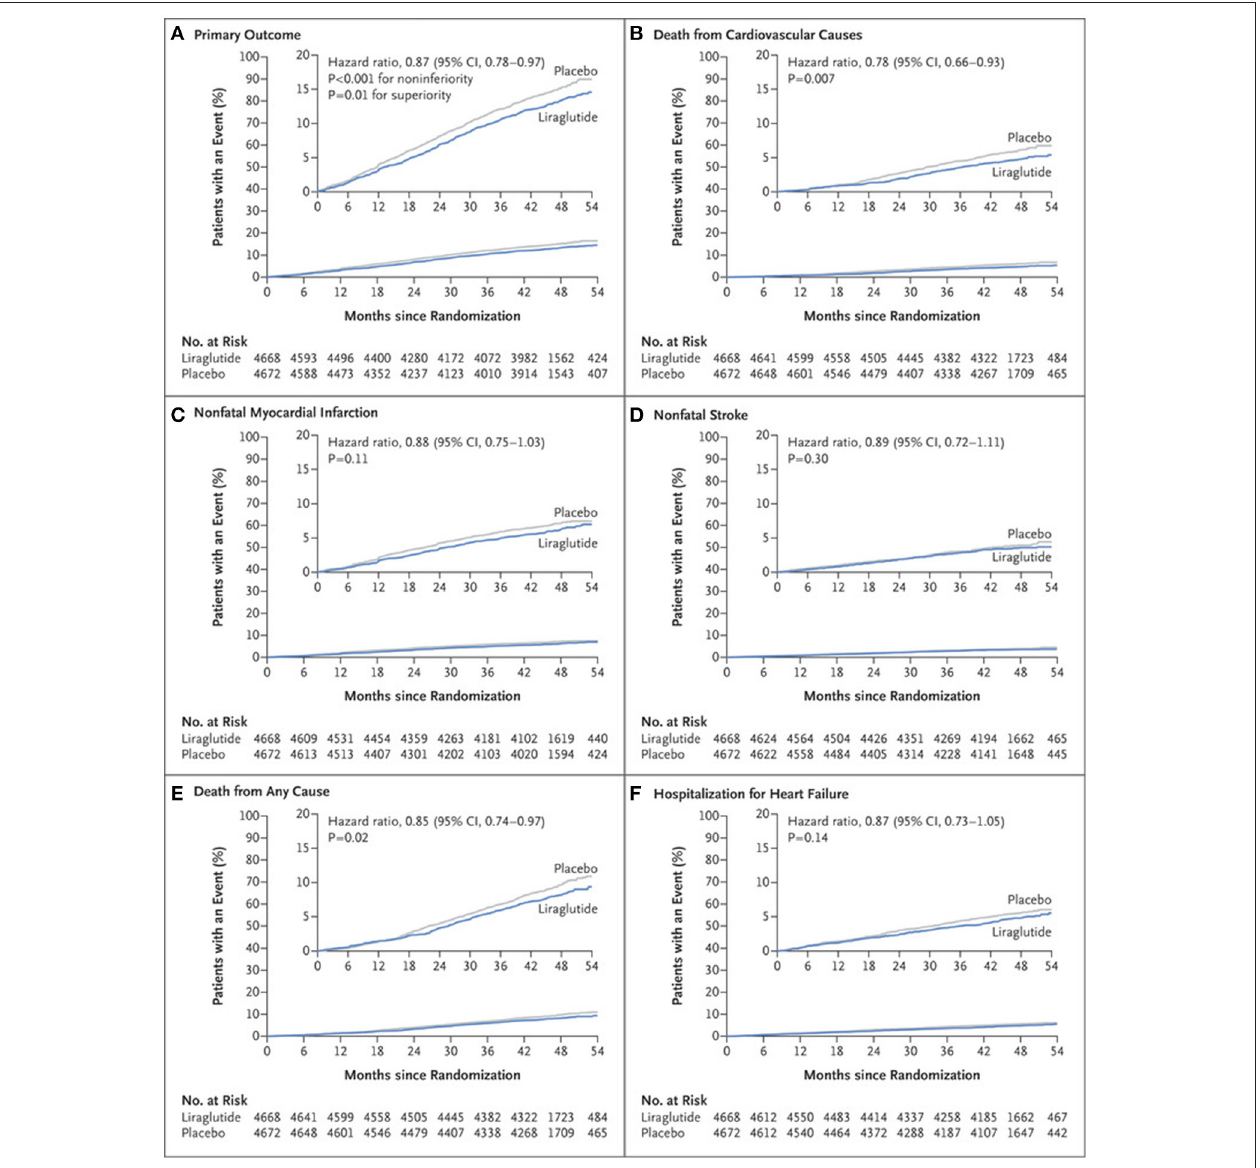
FIGURE 2 | Primary and exploratory outcomes in LEADER trial (32). Cumulative incidence of primary composite outcome (A) ; Cumulative incidence of death from cardiovascular causes (B) ; Cumulative incidence of nonfatal myocardial infarction (C) ; Cumulative incidence of nonfatal stroke (D) ; Cumulative incidence of death from any cause (E) ; Cumulative incidence of hospitalization for heart failure (F) . Copyright 2016. Massachusetts Medical Society. Reprinted with permission from Massachusetts Medical